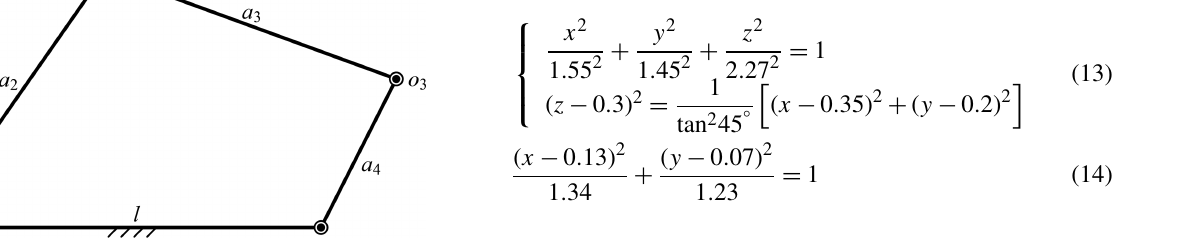
on the plane x p o p y p is shown in Eq.